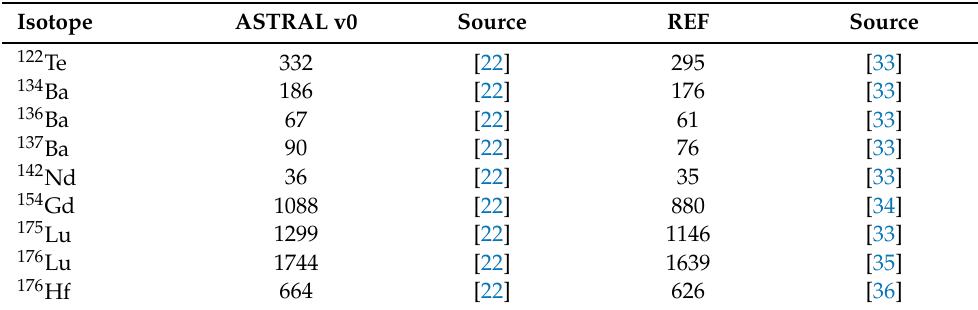
Table 1. Maxwellian averaged capture cross section (in mb) from ASTRAL v0 data set for kT = 30 keV. The values are compared with those of the REF data